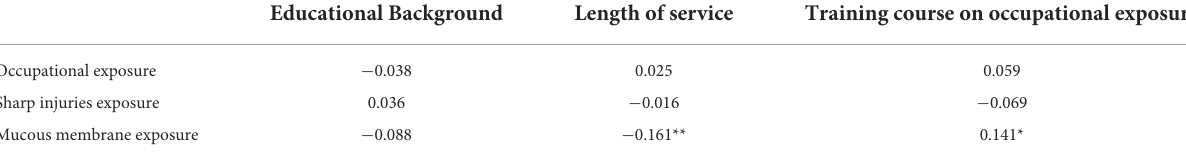
TABLE 4 Correlation between nurses’ characteristics and occupational